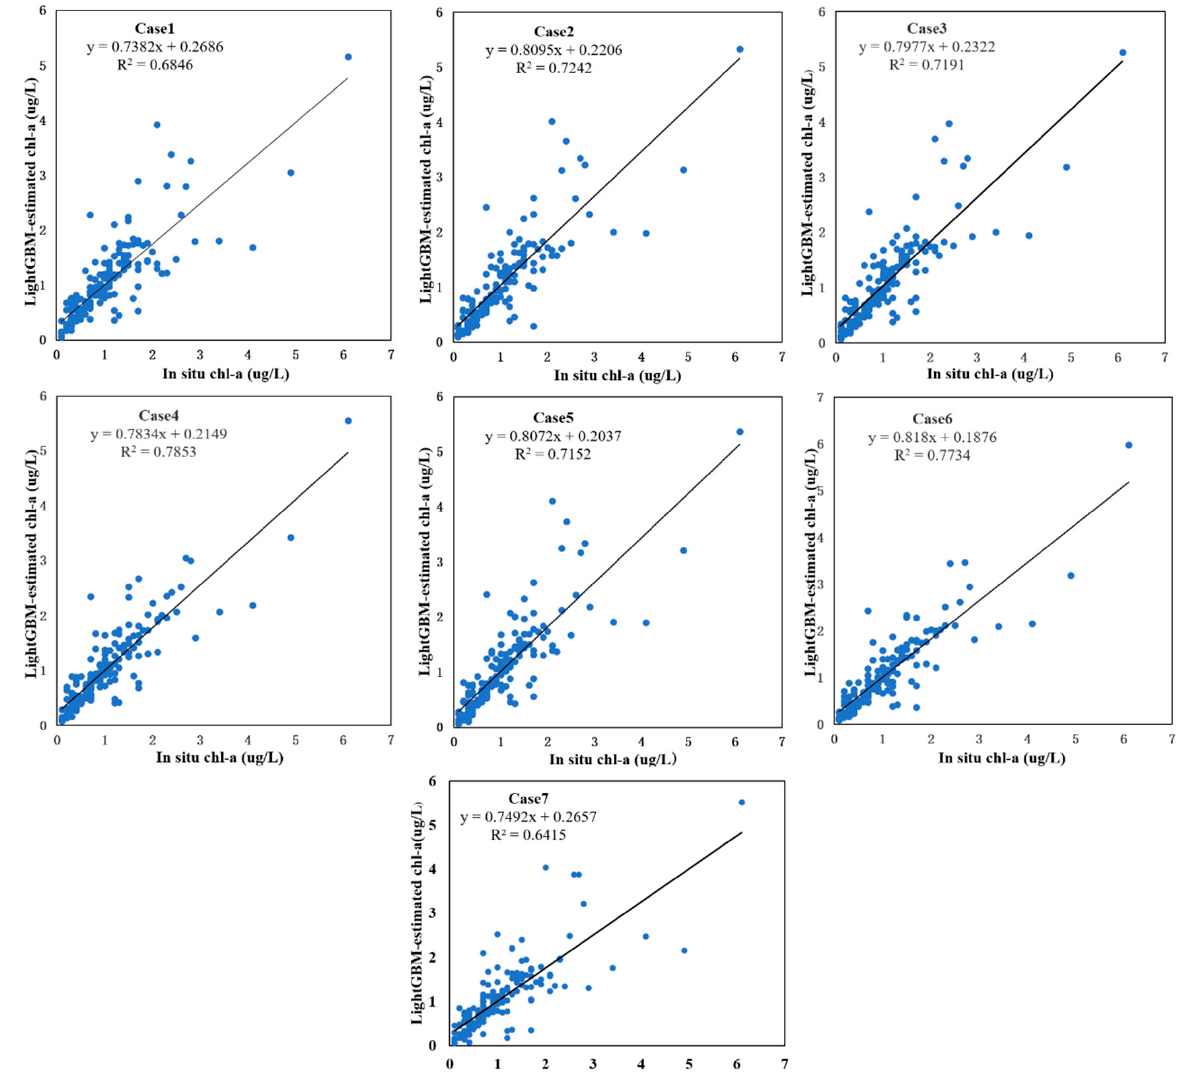
Figure 3. Scatter plots between the LightGBM model ‐ estimated and in situ ch1 ‐ a concentration. Table 5. Performance metrics associated with the LightGBM model ‐ estimated ch1 ‐ a concentration.